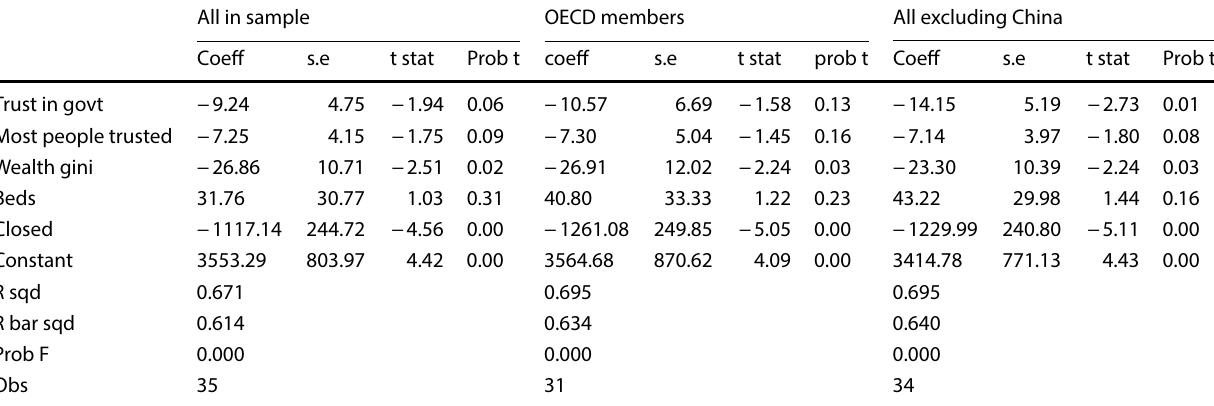
Table 12 Regression results for the second period inc